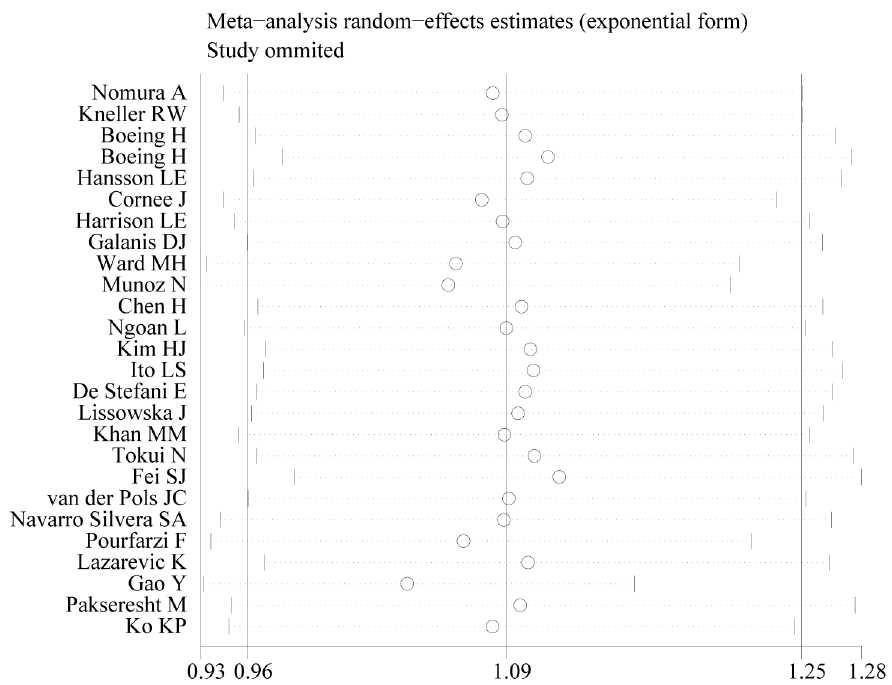
Figure 6. Sensitivity analysis of total dairy intake and gastric cancer risk.